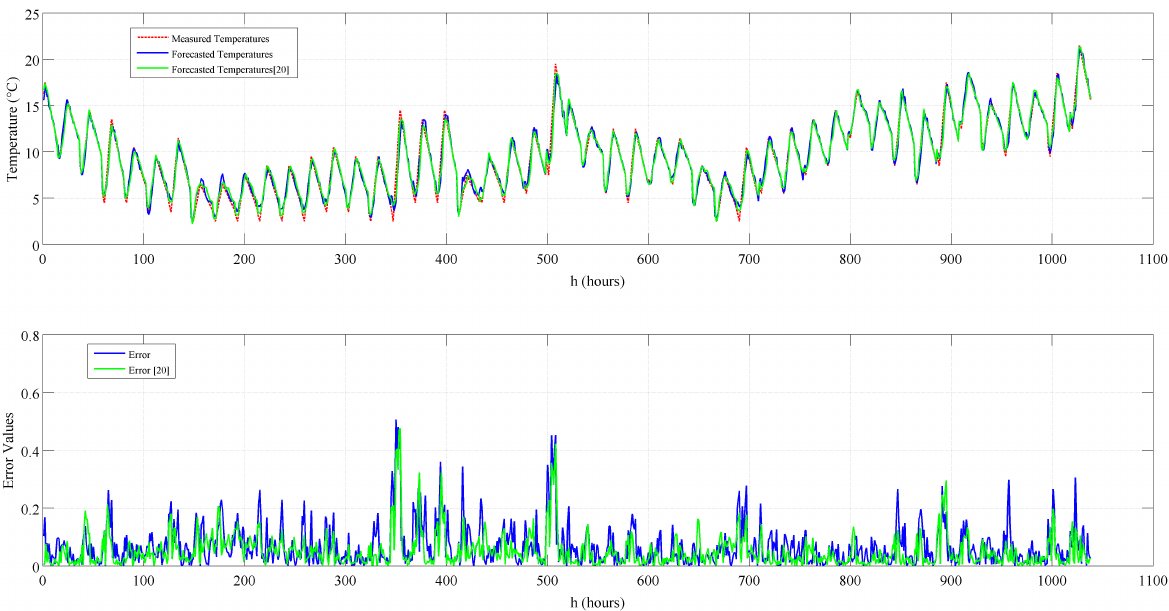
Figure 4. Measures of forecasting indoor temperatures ( top ) and forecasting error ( down ) (winter scenario with 50 neurons in the hidden